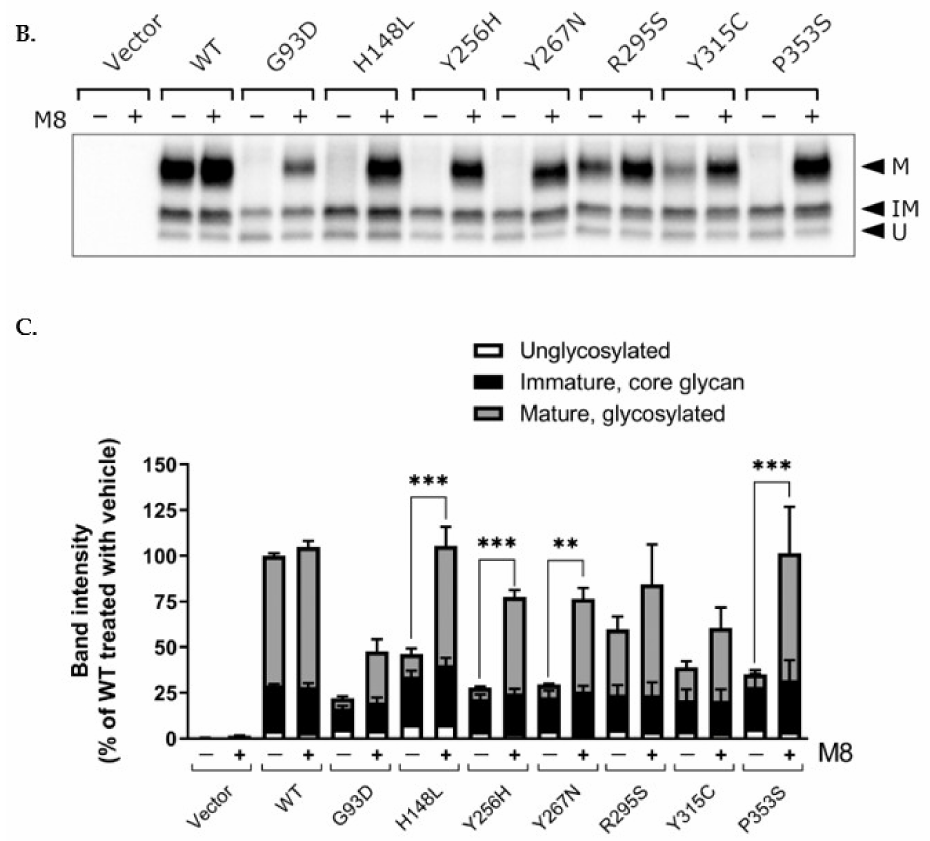
Figure 5. Mutant NK3Rs treated with M8 are post-translationally modified. ( A ) HEK 293-T cells transfected with empty vector or HA-tagged wild-type (WT) NK3Rs were lysed and subjected to Western blotting with an anti-HA antibody. Cell lysates were either untreated (left-hand panel) or were treated in the absence (( − ), mock-treated) or presence ((+), enzyme-treated) of endoglycosidase H (EndoH) or peptide:N-glycosidase F (PNGaseF) enzymes to remove oligosaccharides. ( B ) HEK 293-T cells transfected with empty vector or HA-tagged WT or mutant NK3Rs were treated with 1 µ M M8 (+) or vehicle ( − ), lysed, and subjected to Western blotting with an anti-HA antibody. Mature (M), immature (IM), and unglycosylated (U) receptors are indicated by black arrows. Image is representative of three independent experiments with similar results. ( C ) Densitometry of mature (M), immature (IM), and unglycosylated (U) receptor signals from (B) was performed using ImageLab 6.1.0 (BioRad Laboratories Inc., Hercules, CA, USA). Data are expressed as percentage of WT (treated with vehicle) and are presented as mean ± SEM from three independent experiments. ** p < 0.01 and *** p < 0.001, Student’s t -test for comparison of intensity of mature (M) band between M8 and